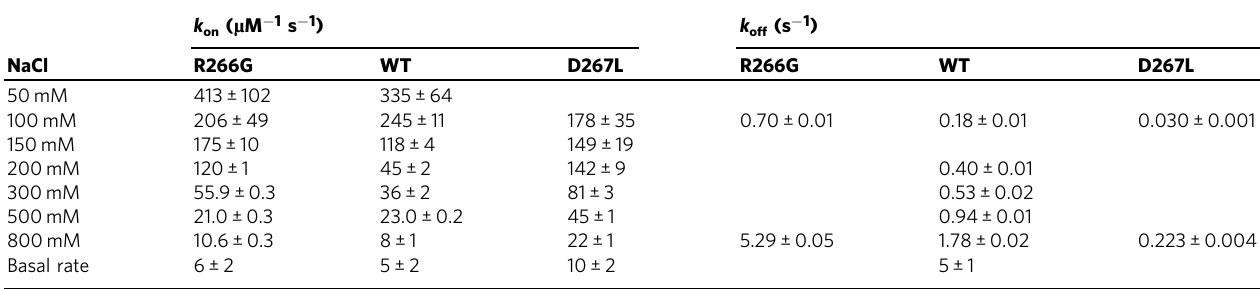
Table 2 Ionic strength dependence of DREB2A(244-272) variants binding to RCD1-RST(499-572).